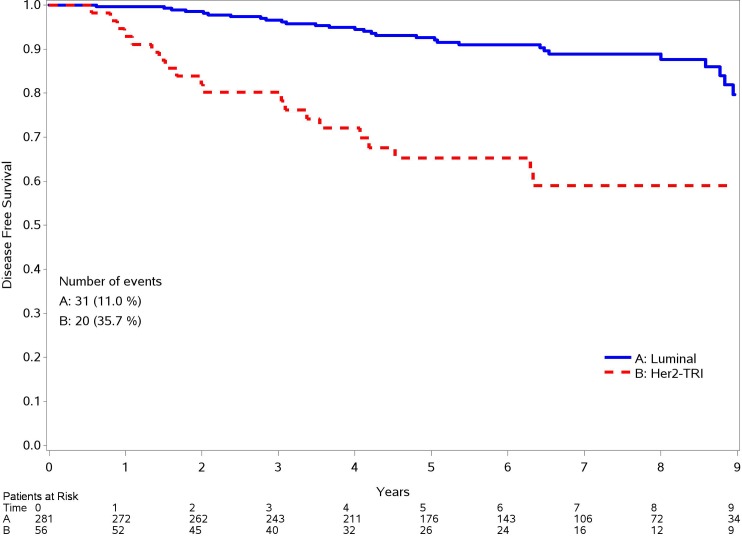
DFS for different molecular subtype.